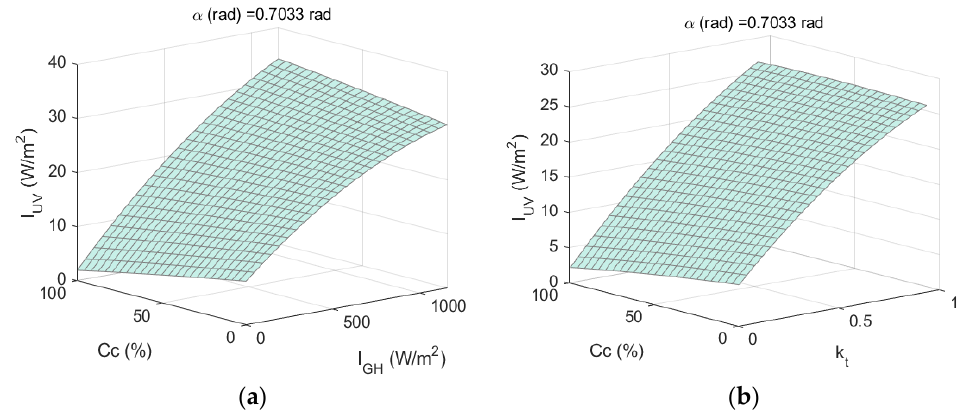
Figure 9. ( a ) I UV vs.(Cc, I GH )| =constant and ( b ) I UV vs. (Cc, k t )| =constant .